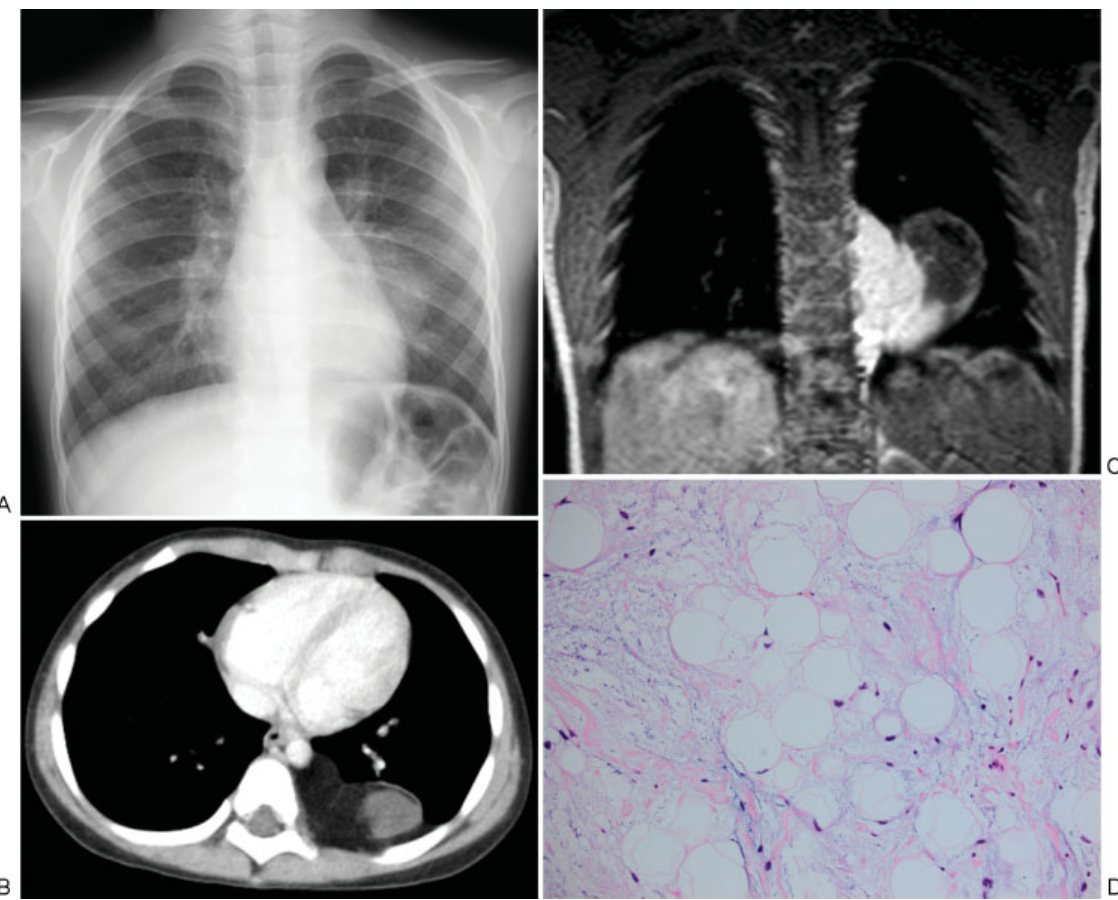
Fig.2 (a) Chest fi lm showing theleft hilar mass. (b) Computed tomography showing the nonhomogenous massin theleftposterior mediastinum, with no contrast enhancement. (c) T1-weighted magnetic resonance imaging of the chest showing the mass near the vertebrae and ribs, with a signal intensity of nonadipose tissue component. (d) Histologic view showing mature and immature adipocytes (hematoxylin-eosin, original magni fi cation (cid:1) 20).